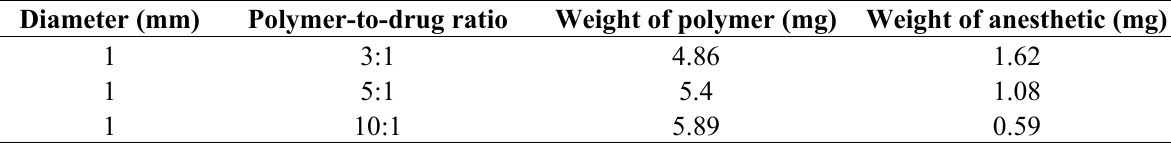
Table 1. Dimensions and compositions of the lidocaine/PLGA pellets of various polymer-to-drug ratios.